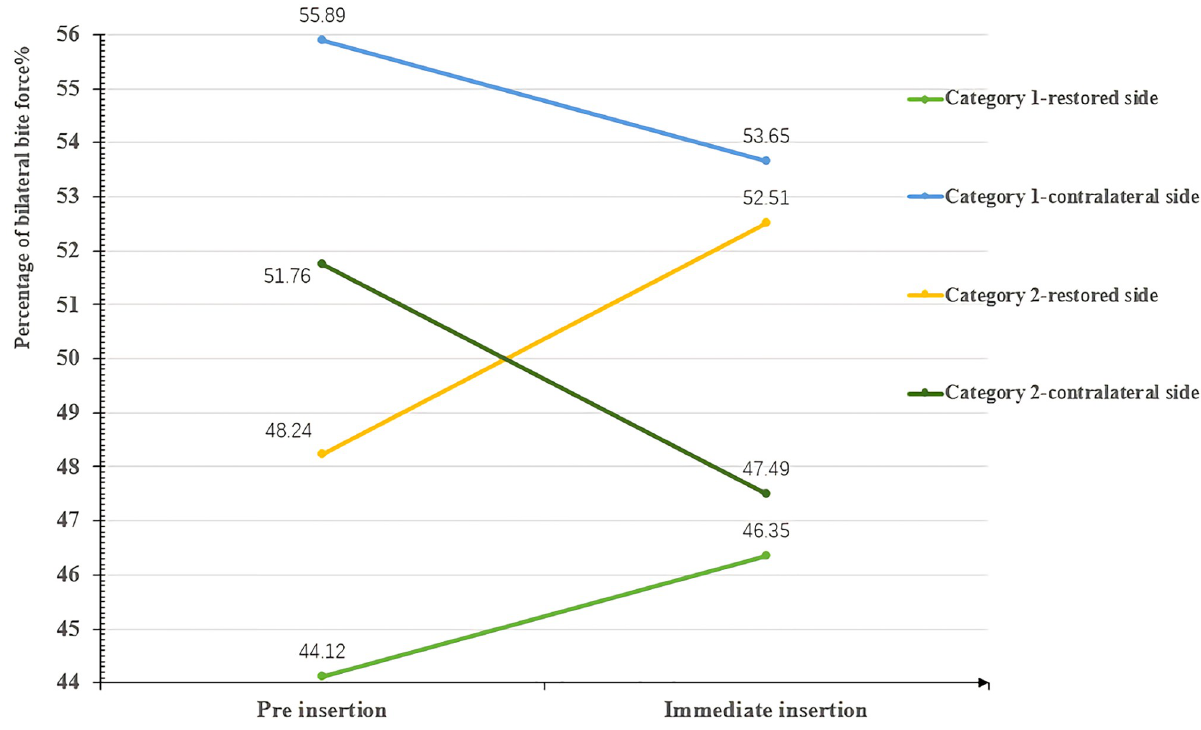
Fig 4. Changes in the average bilateral bite force (before treatment vs immediately following